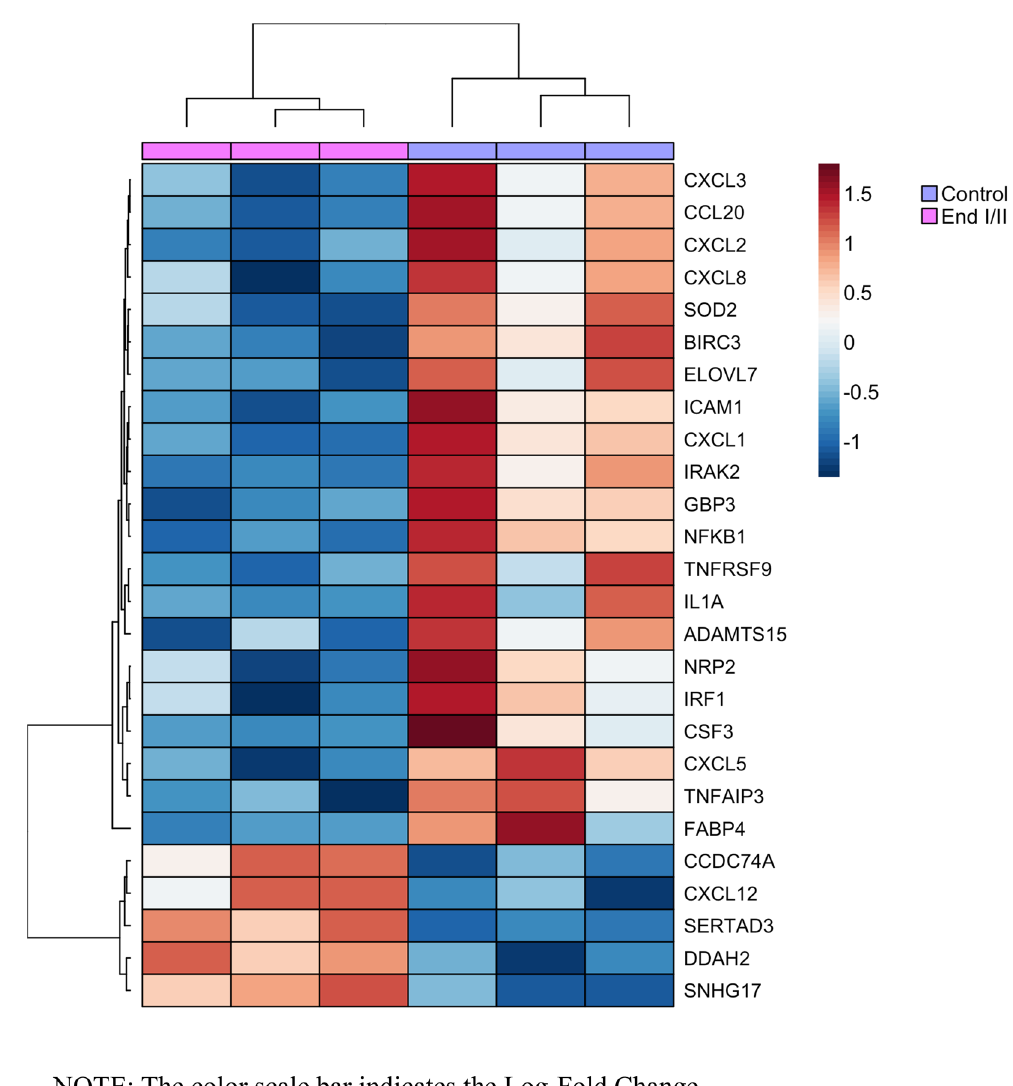
Figure 2. Unsupervised heatmap of the 26 DEGs of CCs from patients with endometriosis I/II compared to the